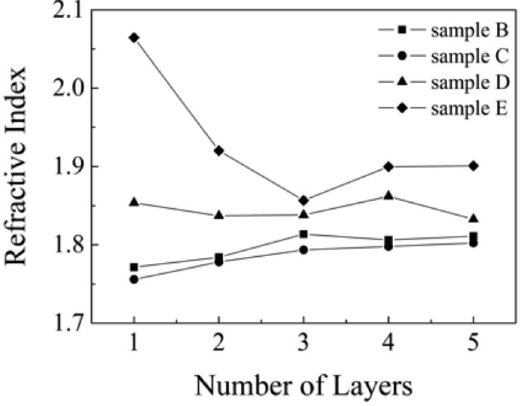
Figure 6. A schematic outline of the used ellipsometric model.